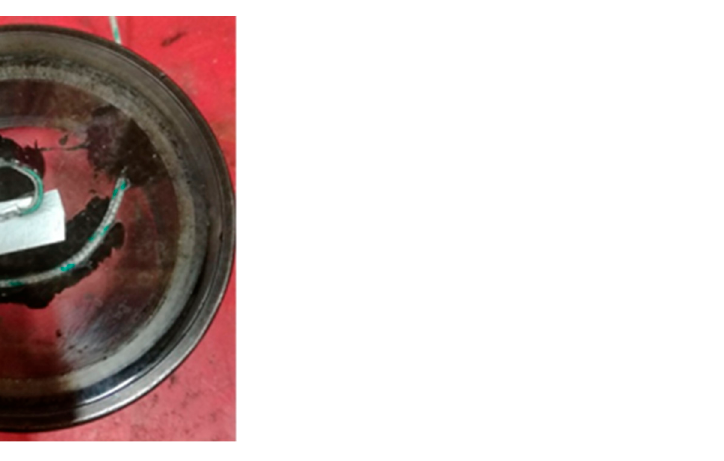
Figure 2. Piston window instrumented with a K-type thermocouple [17]. Reprinted with permission